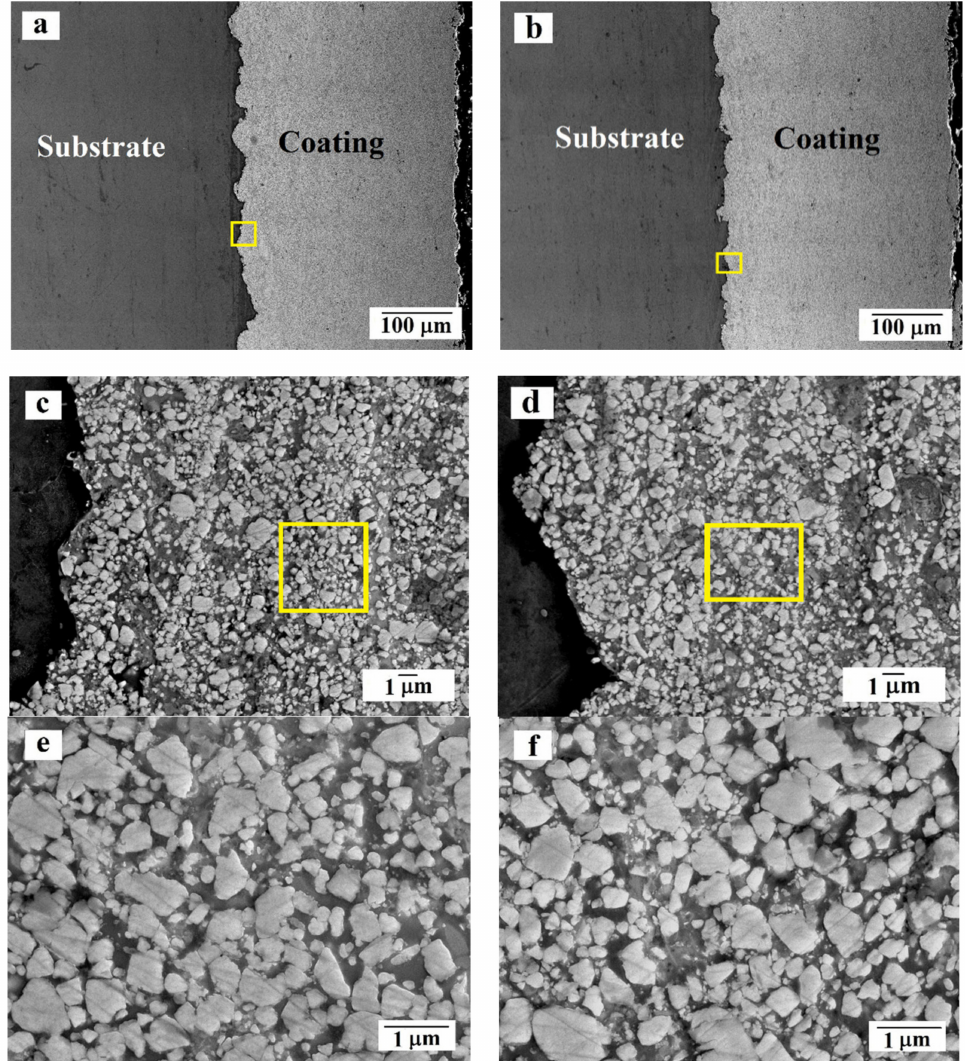
Figure 6. Morphology and microstructure of the cross section of the samples: ( a , c , e ) sample of batch 1; ( b , d , f ) sample of batch 2. Enlarged areas in the figures are indicated with yellow